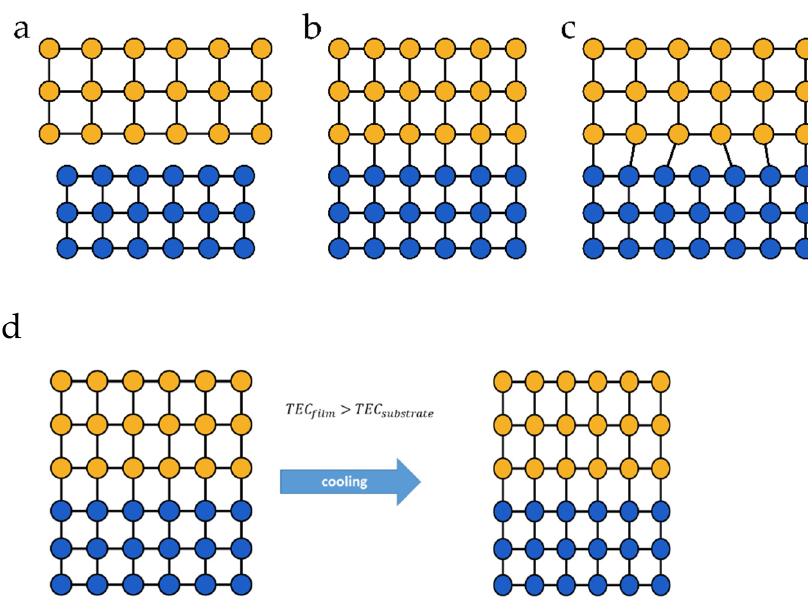
Figure 1. Origins of the strain in a thin film: ( a ) illustration of a lattice mismatch of the film (yellow) and the substrate (blue); ( b ) elastically strained film; ( c ) a misfit dislocation which forms if a lattice mismatch exceeds a critical value; ( d ) if the film and the substrate differ in TEC, at the temperature of a deposition only the strain originating from the lattice mismatch is present but below or above the deposition temperature, an additional contribution to strain appears. If TEC film > TEC substrate at temperatures below the deposition temperature, the film is additionally compressed.